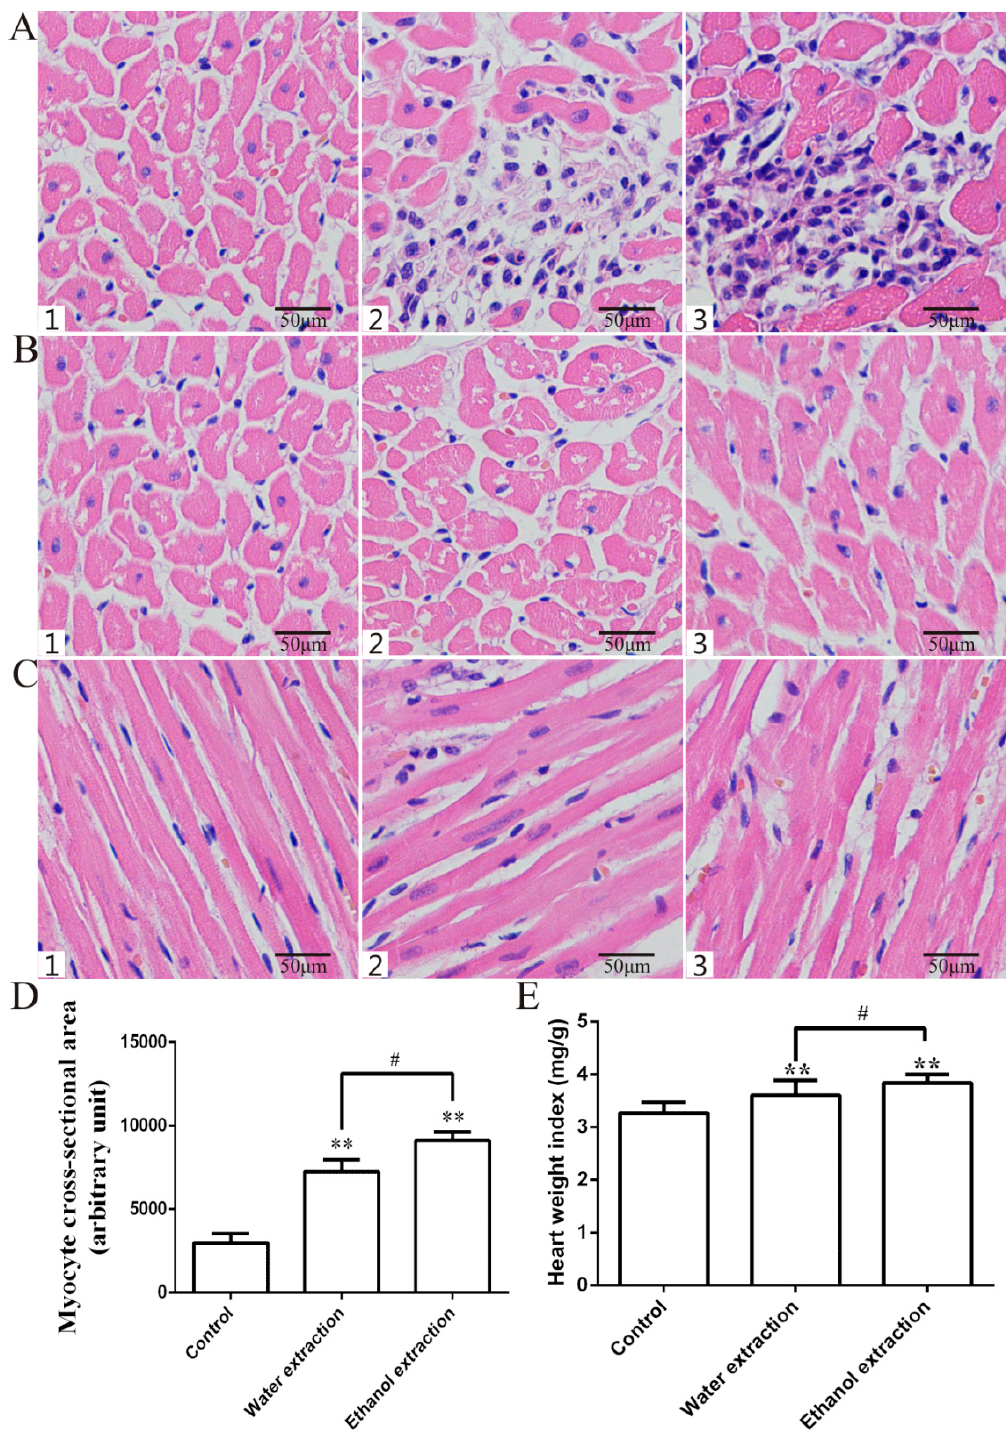
Figure 3. Histopathological examination of heart, HW/BW, and myocyte CSA. ( A , B ) Representative figure of myocyte cross-section (hematoxylin-eosin staining (HE) staining, 400 × ); ( D ) Statistic results of myocyte CSA. 1: Control group; 2: Water extraction group; 3: Ethanol extraction group; ( C ) Representative figure of myocyte long axis (HE staining, 400 × ); ( E ) Statistic results of HW/BW; data are expressed as mean ± SD, n = 8. ** p < 0.01 vs. control group; # p < 0.05, vs. water extraction group.